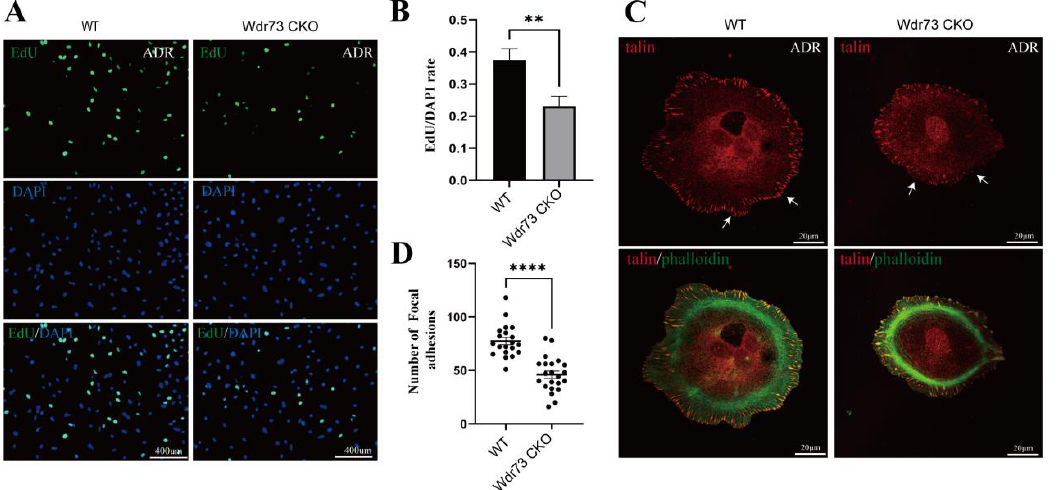
Figure 7. WDR73 was required for focal adhesion assembly in podocytes. ( A , B ) WDR73 depletion inhibited podocyte proliferation. Proliferating ADR-treated mice primary podocytes were labeled with EdU (green) and cell nuclei were stained with DAPI (blue). n = 3, ** p < 0.01 ( t -test). Error bars represent mean ± SEM. Scale bars, 400 μm each. ( C , D ) WDR73 KO led to abnormal focal adhesion formation. Disrupted focal adhesions (white arrows) and quantification of the number of FAs per cell are indicated in ADR-treated mice primary podocytes. Focal adhesion marker talin (red), microfilament (green), n = 20, **** p < 0.0001 ( t -test). Error bars represent mean ± SEM. Scale bars, 20 μm each.